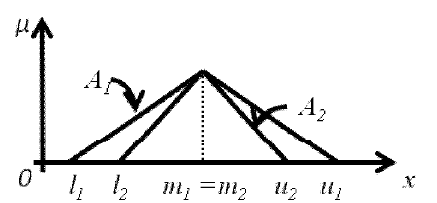
Fig. 1. Two fuzzy numbers having identical centroid points